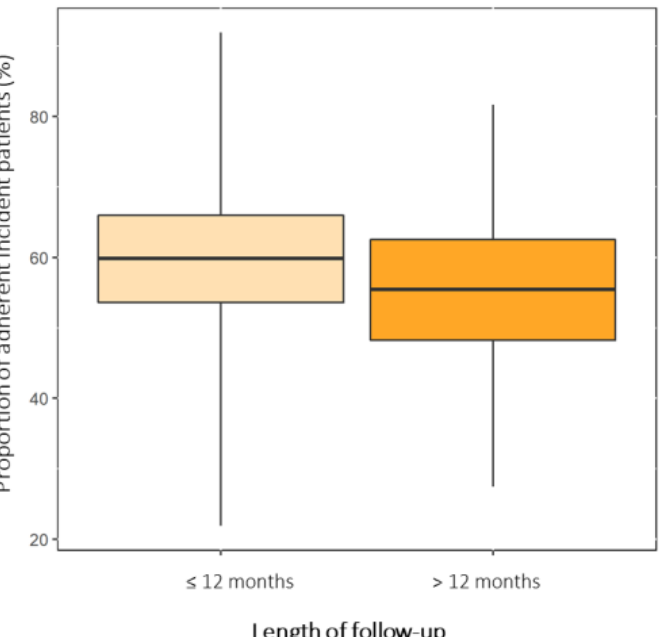
Figure 2. Pooled proportions of adherent incident patients stratified by length of follow-up. The width of boxes represents the 95% confidence intervals, while the whiskers extend for the 95% prediction intervals.